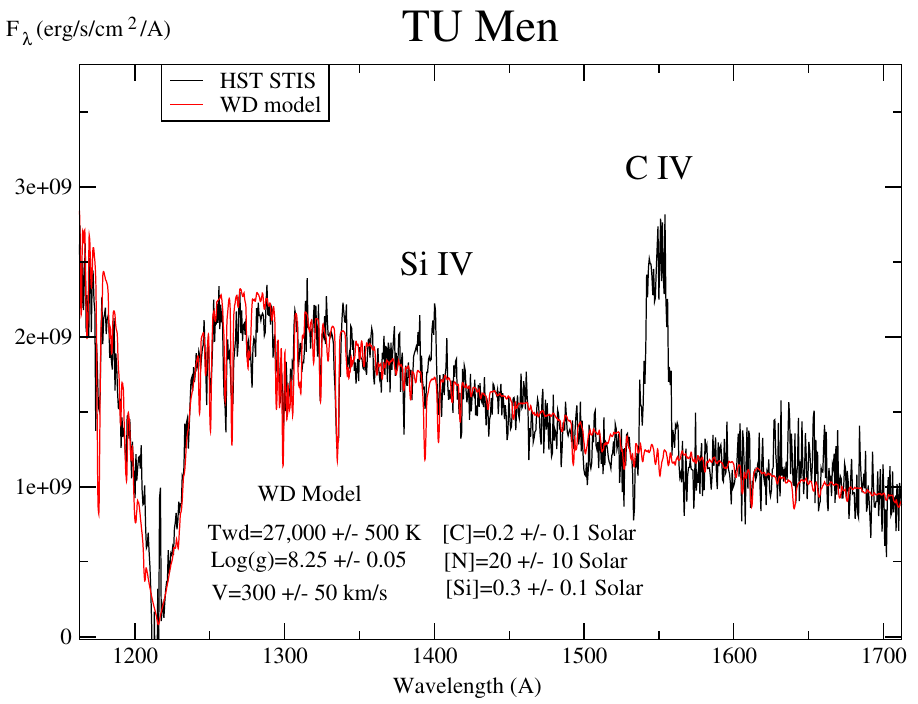
Figure 2. Modeling the WD in TU Men. The HST STIS FUV spectrum of TU Men (in black) is fitted with a synthetic stellar spectrum (in red). The results of the model fit, for a Gaia distance of 277 pc, give an effective surface gravity of Log ( g ) = 8.25 ± 0.05, with an effective surface temperature of 27,000 ± 500 K. The elemental abundances are varied one by one together with the projected rotational stellar velocity. The fitting of the lines yields a carbon abundance of [ C ] = 0.2 ± 0.1, silicon abundance of [ Si ] = 0.3 ± 0.1, and nitrogen abundance of [ N ] = 20 ± 10, all in solar abundances (sun = 1). The resulting projected stellar rotational velocity from the lines is V rot sin ( i ) = 300 ± 50